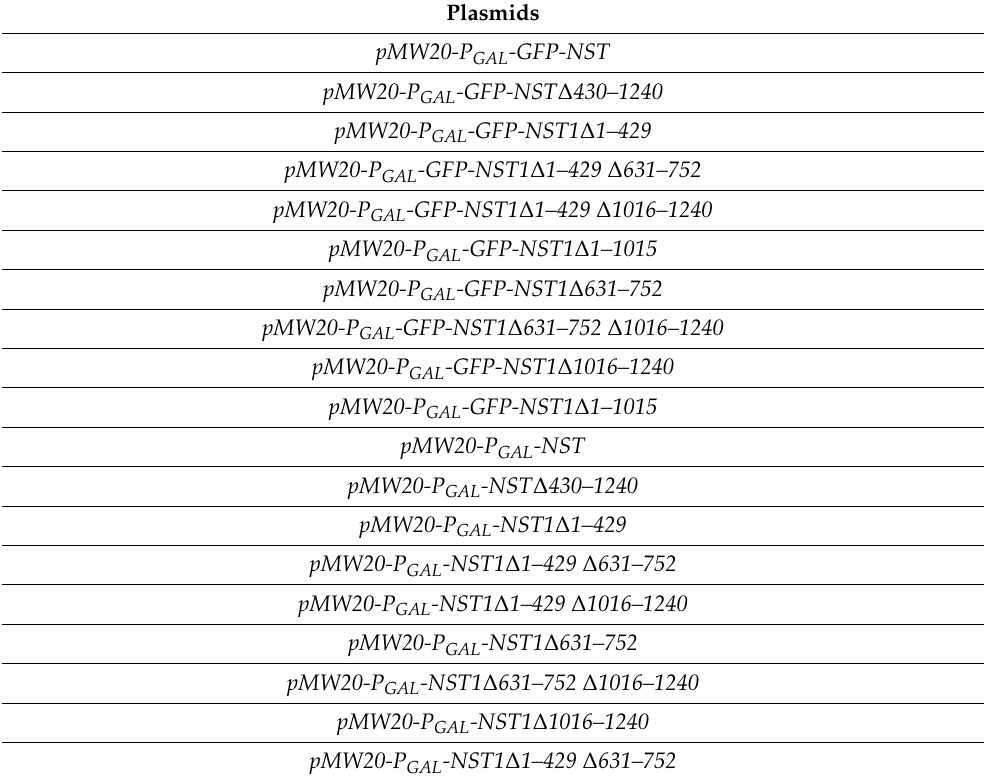
Table 2. The plasmids used in this